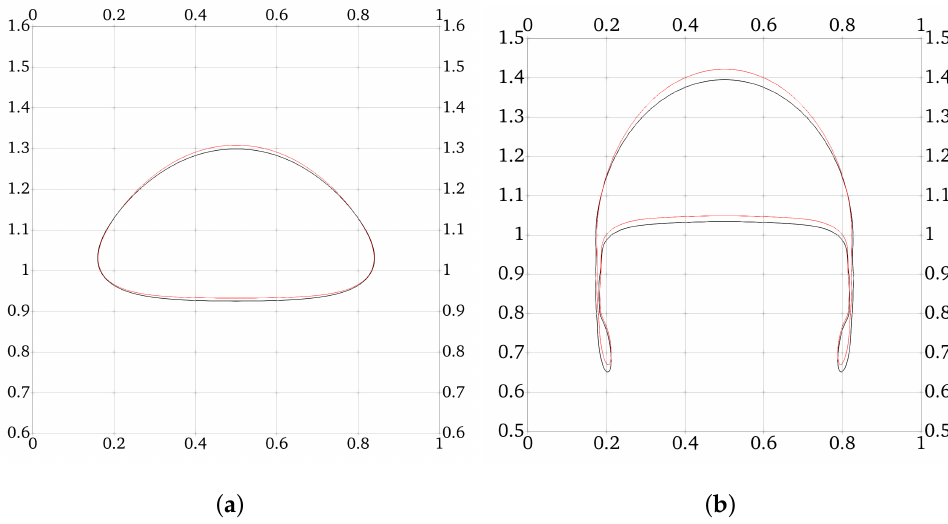
Figure 11. The shape of the interface in the two-dimensional rising bubble simulation, t = 3. The red line indicates the results of the AMR grid with a finest resolution of 256 × 512 and the black line indicates the results of the AMR grid with a finest resolution of 512 × 1024. ( a ) Case A. ( b ) Case